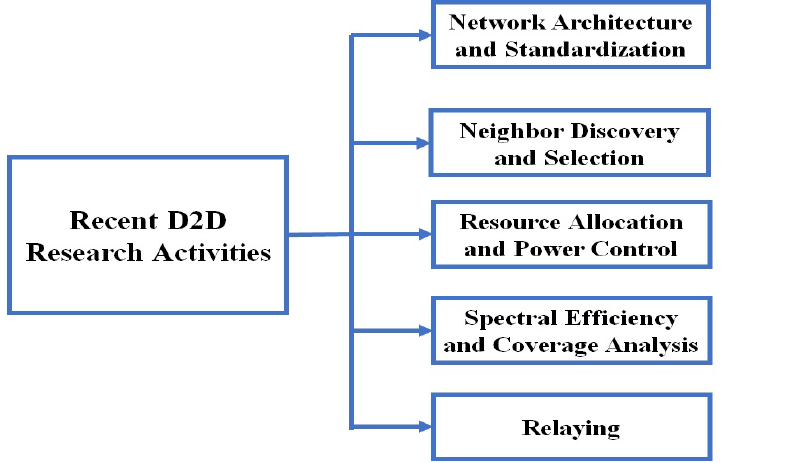
Figure 2. Recent D2D research